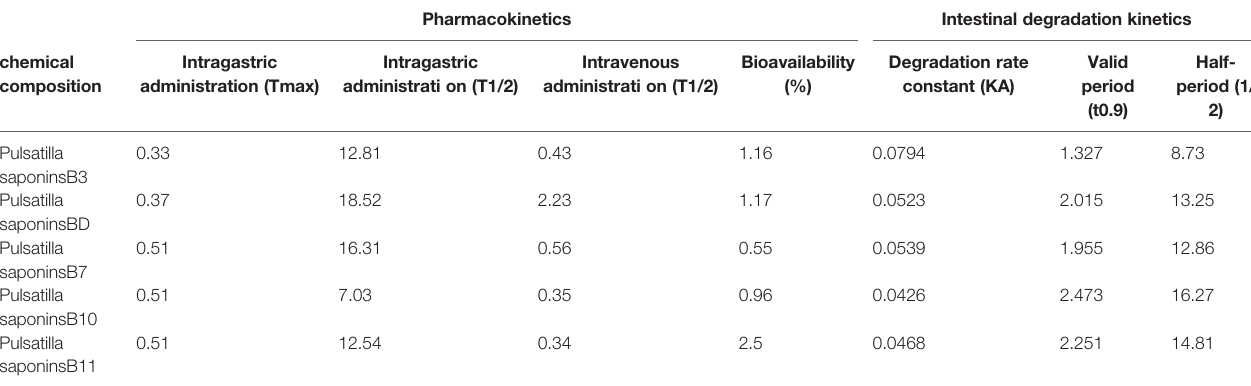
TABLE 3 | The pharmacokinetic study of the main active